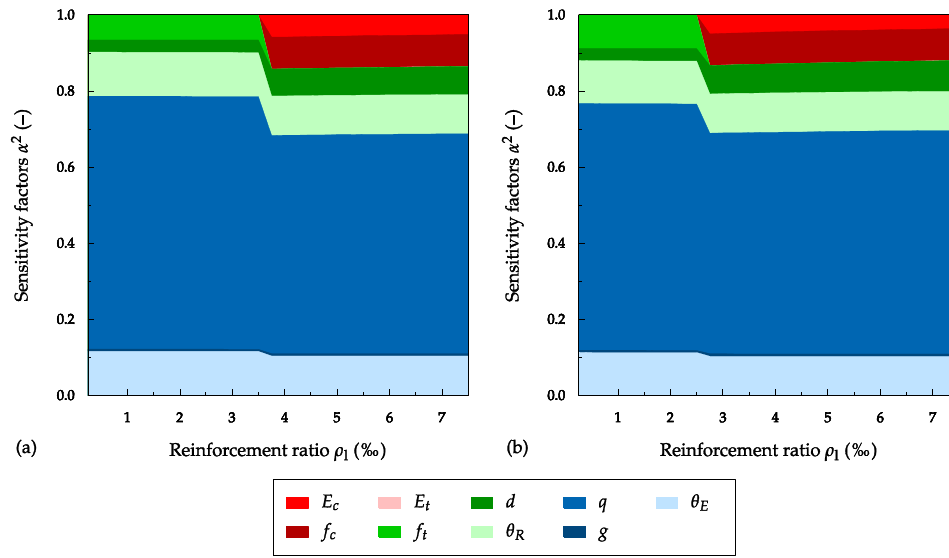
Figure 11. Sensitivity factors calculated for γ T = 1.3 according to FORM: ( a ) AR-glass textiles; ( b ) carbon textiles.